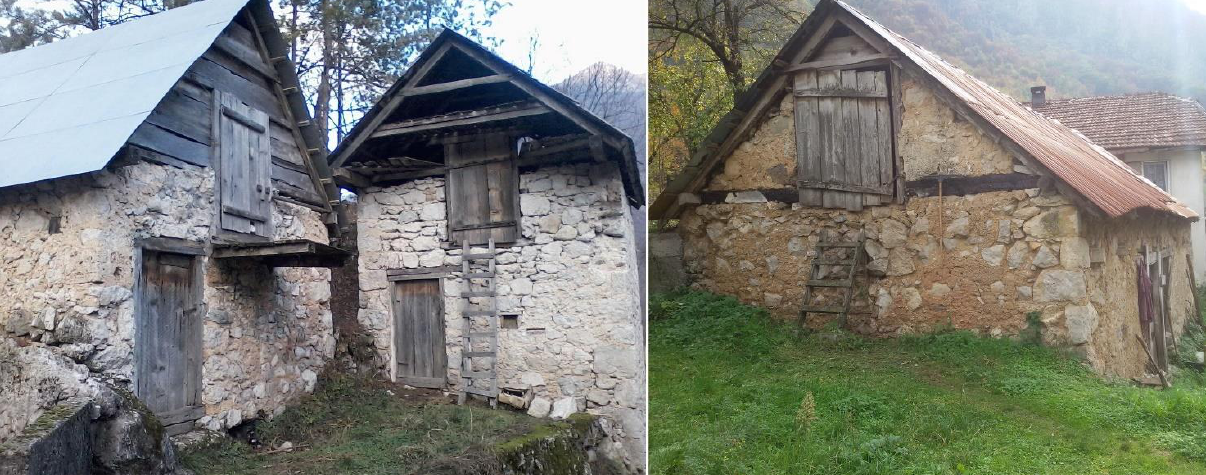
Figure 5. Storages and barns in the hamlets Kasali and Nuhići.(Source: